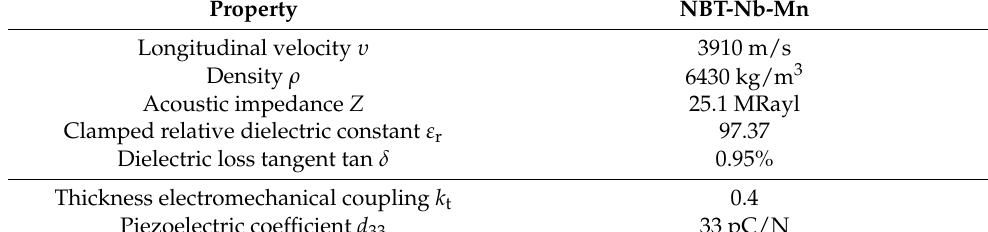
Table 2. Parameters of piezoelectric materials used for PiezoCAD simulation modeling.